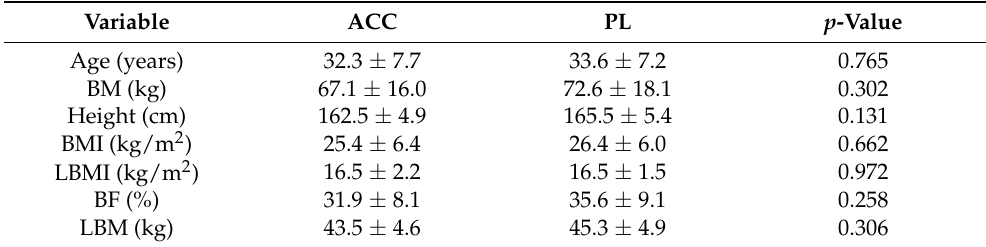
Table 1. Participants’ characteristics for the ACC ( n = 14) and the PL ( n = 17) groups. p values are generated from a two-sided independent samples t -test.